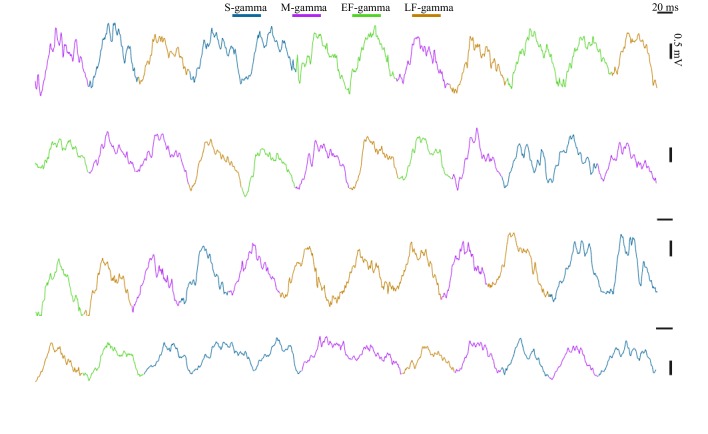
LFP examples during awake sessions.LFPs recorded from four rats (each row is from one rat). Color codes denote clustering of individual theta cycles through k-means clustering.